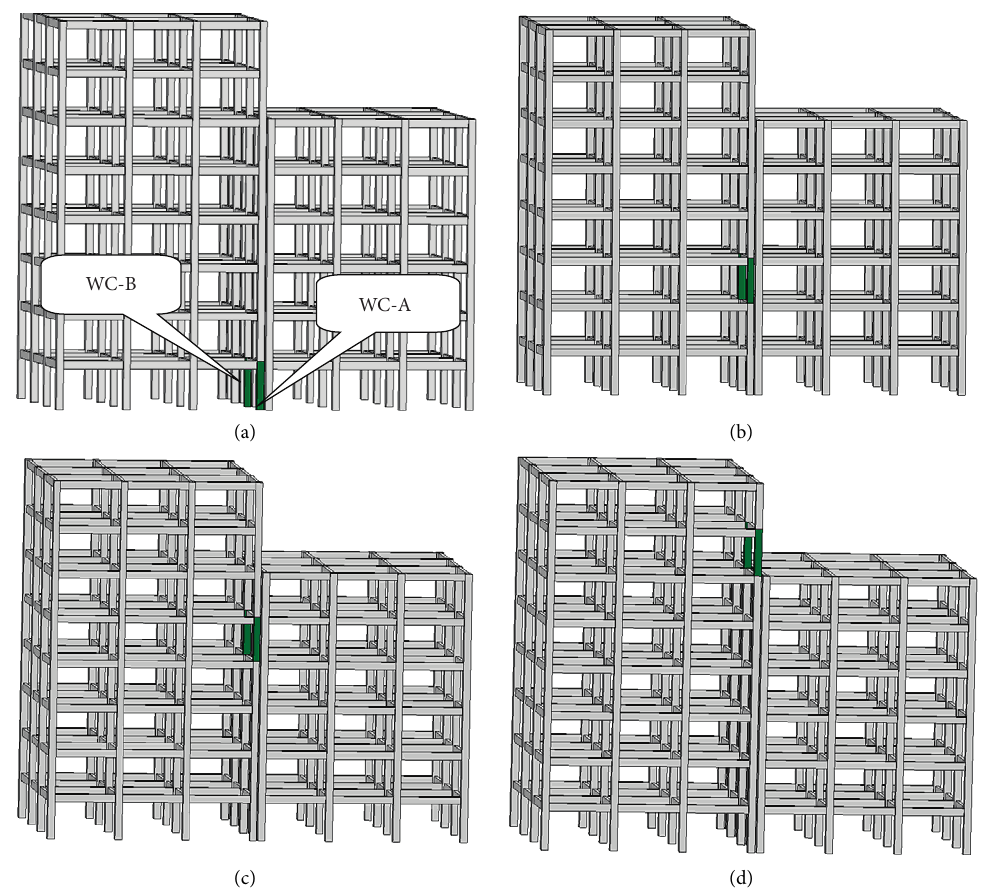
Figure 5: Locations of weak column: (a) GK-1; (b) GK-2; (c) GK-3; and (d) GK-4.